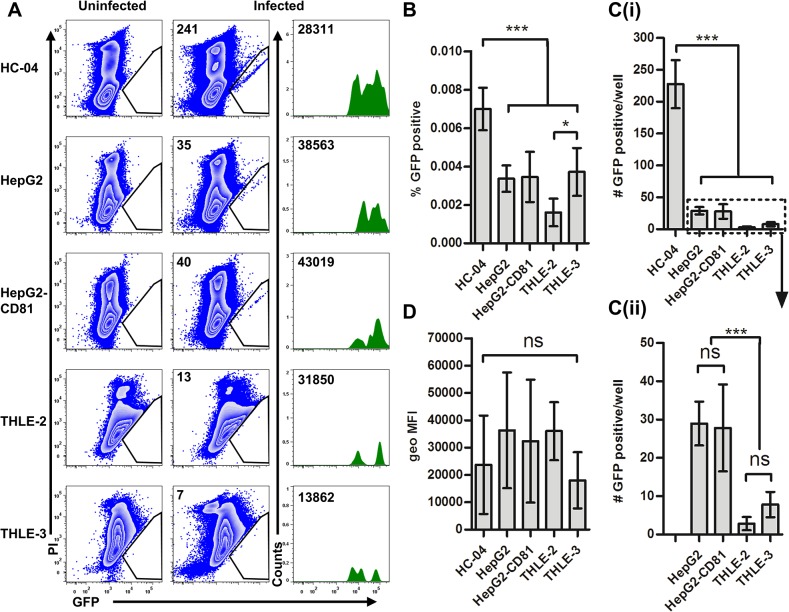
Identification of hepatocytes infected with P. falciparum 3D7HT-GFP parasites by flow cytometry.Sporozoites were added at a 2.3:1 sporozoite-to-hepatocyte ratio. Infected cells were identified by flow cytometry at 96 hours postinfection as GFP-positive events in PI-negative (viable) cell populations. Uninfected cultures propagated in parallel with infected cultures were used to define specificity of GFP-positive events. A similar number of total events were acquired from infected and uninfected cultures of each cell lines. (A) Data from one representative culture is shown for each cell line. Event number corresponding to the GFP-positive gate (middle panels) and the geometric mean of events in the GFP-positive gate is indicated (right panels). (B) Percentage of GFP-positive PI-negative events. (C) Number of GFP events per well (D) Geometric MFI in FL-1 of GFP-positive PI-negative events. Mean +/- SD shown for all bar graphs (n = 6 per cell line).